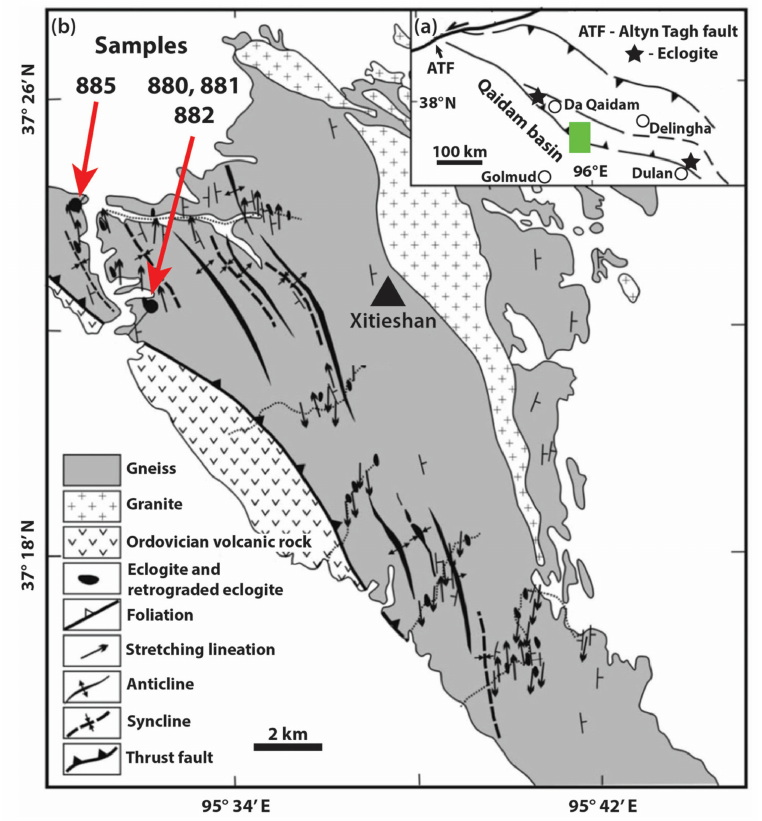
Figure 1. ( a ) Schematic geological map showing the North Qaidam ultra-high-pressure (UHP) metamorphic belt, northwestern China. ( b ) Study area and geological map of Xitieshan area. Green rectangle area in ( a ) was magnified (modified after Zhang et al.